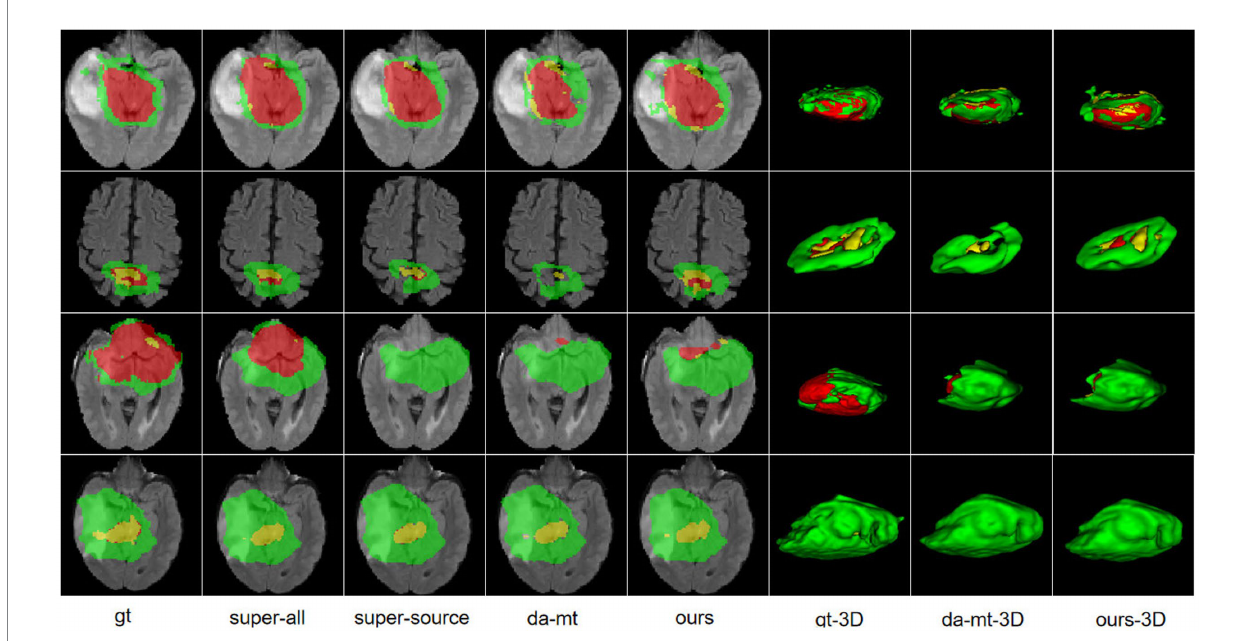
FIGURE 3 Illustration of the segmentation results of different unsupervised domain-adaptation methods in the high-grade glioma to low-grade glioma experiments. Yellow indicates the enhancing tumor core class. Yellow + red indicates the tumor core class. Yellow + red + green indicates the whole tumor class. gt, ground truth; da-mt; domain adaptation using mean teacher; ours, our